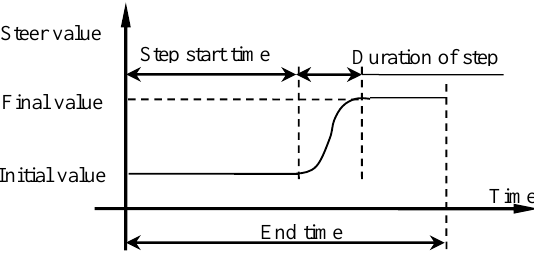
Figure 13. The curve of the input versus the time for the step steer test.